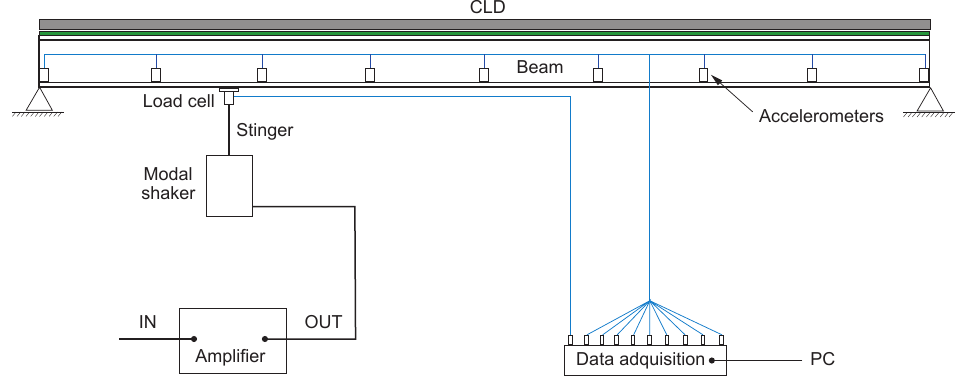
Figure 4. Schematics of excitation and measurement